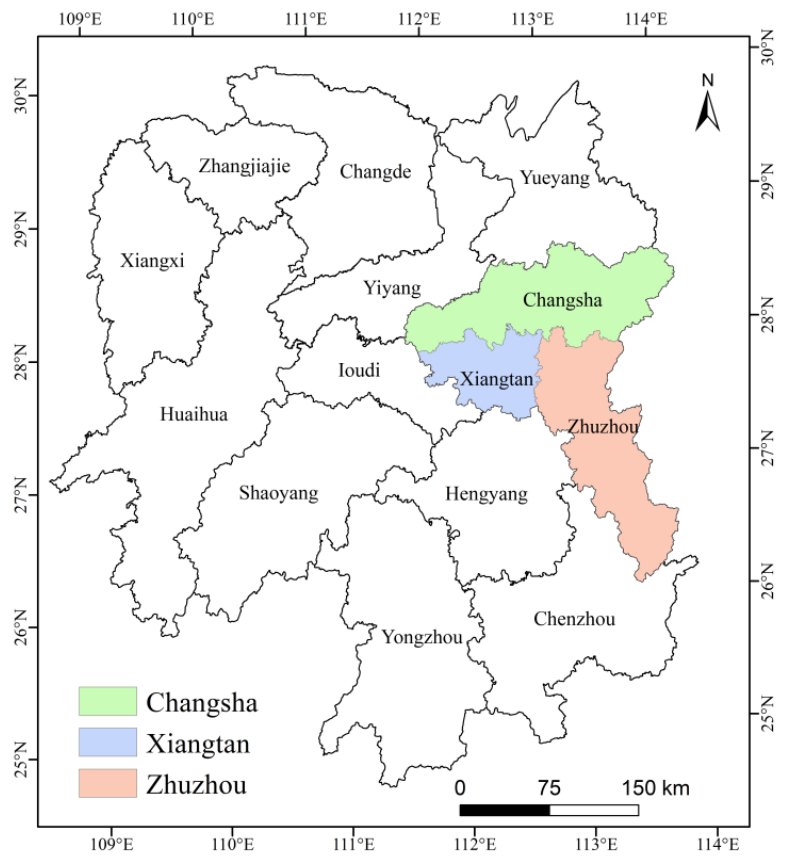
Figure 1. Location of the Chang-Zhu-Tan urban agglomeration.